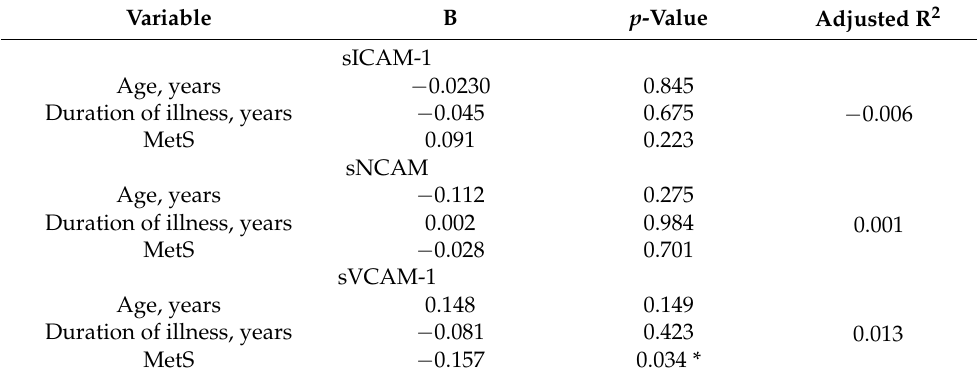
Table 6. Determinants of CAMs’ concentrations in multiple regression analysis, with age, duration of schizophrenia, and MetS as independent